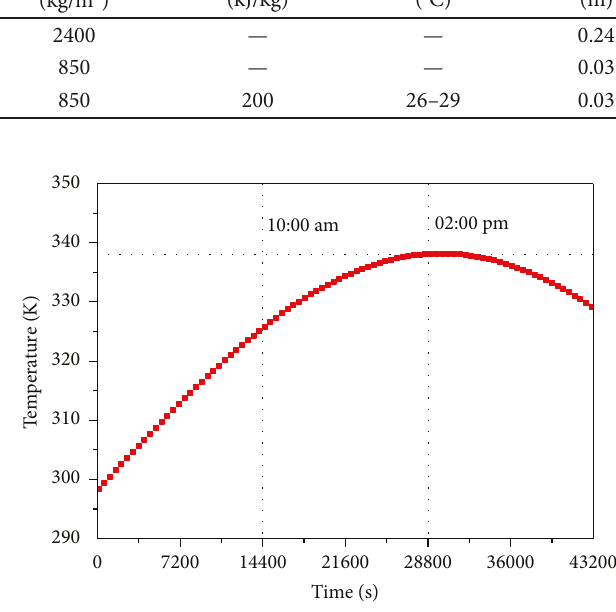
Figure 3: Total solar radiation of the Xuzhou area in di ff erent